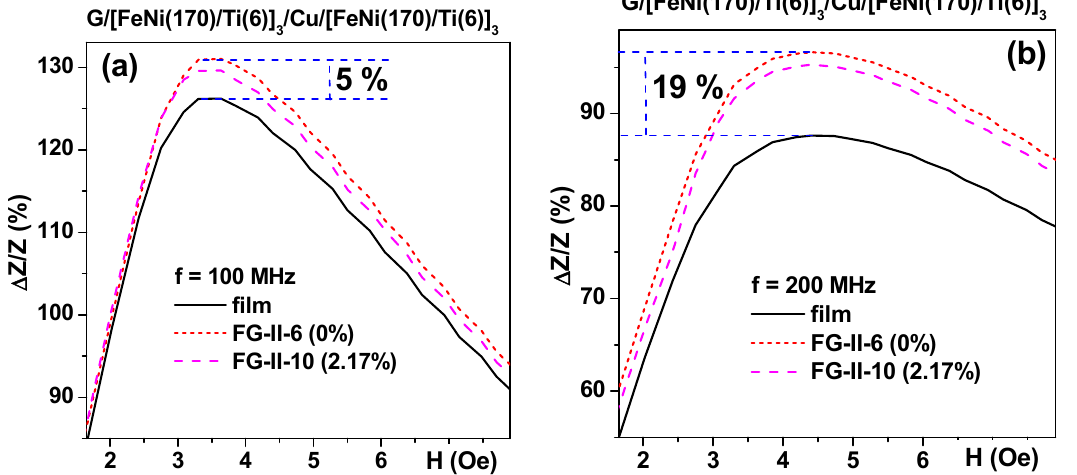
Figure 11. Field dependence of the Δ Z / Z ratio for thin film FeNi/Ti-based MI sensitive element measured either without gel/ferrogel or in the presence of gel or ferrogel with maximum available concentration of MNPs: ( a ) f = 100 MHz; ( b ) f = 200 MHz. Dashed lines show the difference between the MI element itself and the MI element covered by gel. G-glass substrate, numbers in the description of the multilayered structure are layer thicknesses. All units for the layers thicknesses are nanometers.